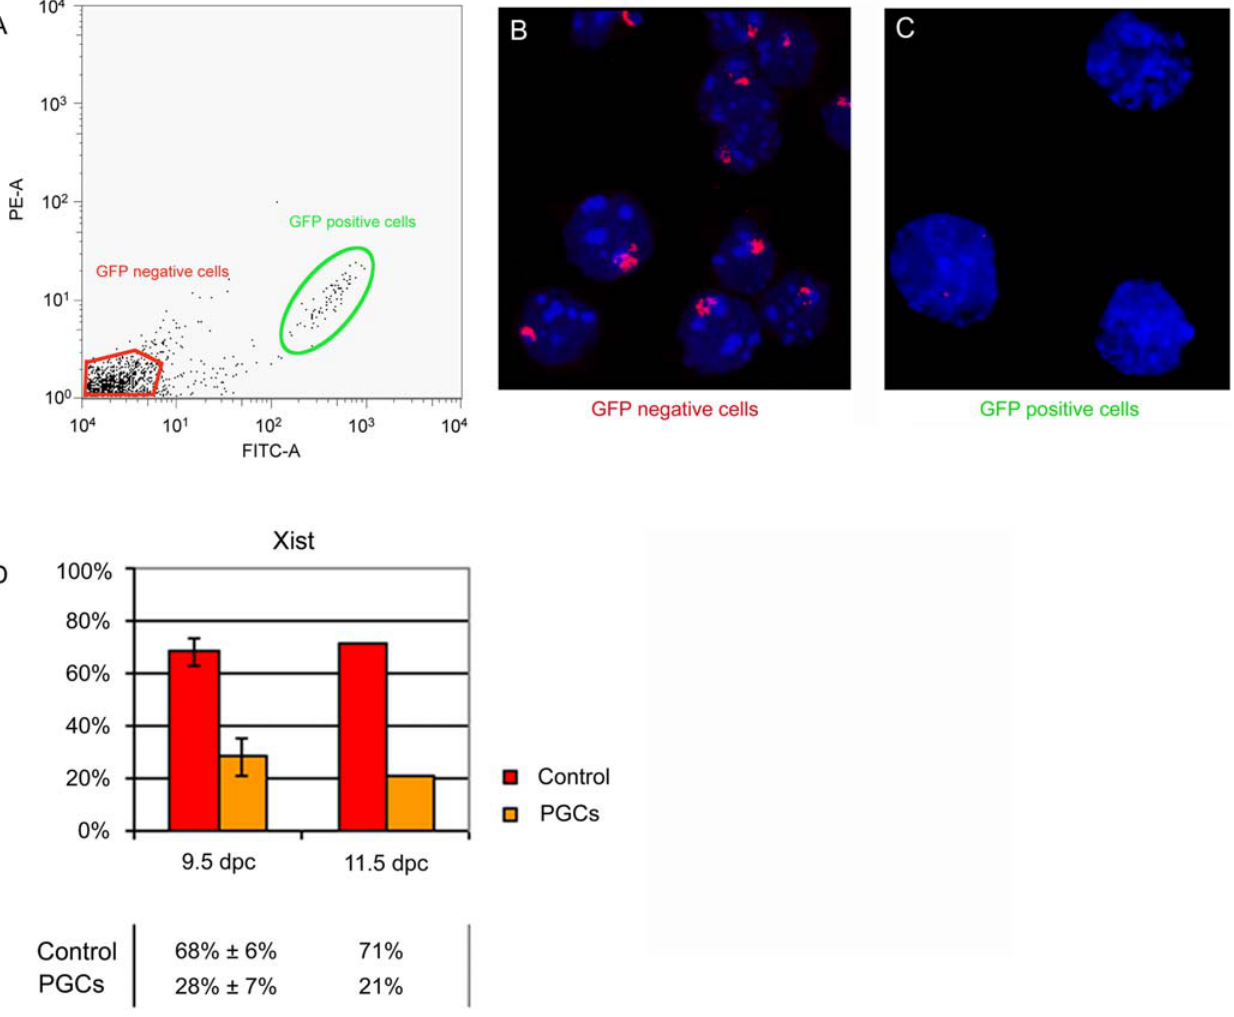
Figure 3. Xist RNA expression in XX PGCs. (A) Example of FACS plot showing GFP-positive and GFP-negative cell populations collected for analysis from dissociated genital ridges of female Oct4-GFP embryos. GFP intensity is shown on the X axis. (B) Example of RNA FISH analysis detecting Xist RNA in the Oct4-GFP negative cells shown in (A). (C) Example of RNA FISH analysis showing Xist RNA domains are absent in the majority of the Oct4- GFP positive PGCs shown in (A). (D) Scoring results showing proportion of cells from XX embryos with Xist RNA domains in Oct4-GFP positive cell (PGCs) compared to unsorted dissociated cell (control) populations. For 9.5 dpc 105 FACS sorted and 405 control cells obtained in two independent experiments were scored. For 11.5 dpc data 140 FACS sorted and 262 control cells were